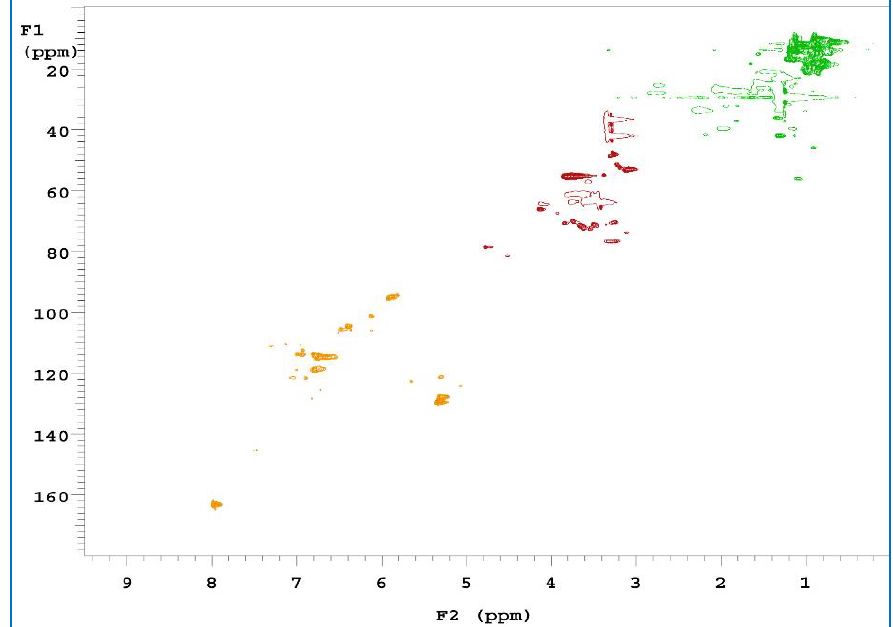
Figure 9. 2D-HSQC NMR spectra of RPB ethanol/benzene extract.